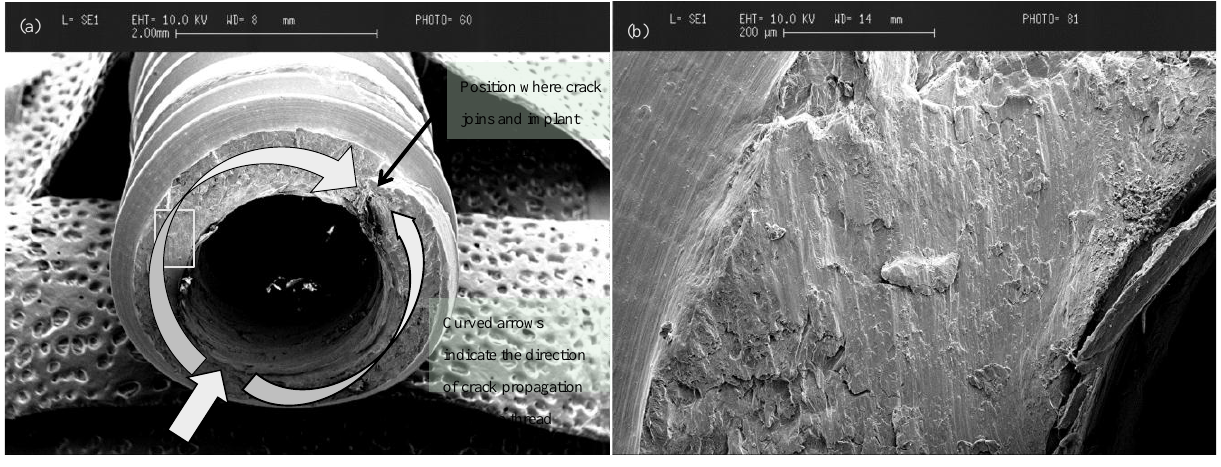
Figure 1. ( a ) Low magnification (×25) SEM image of fractured titanium implant. The crack in this instance was initiated on the lower left edge of the implant (lower straight arrow) and extended around the thread, finally breaking when the cracks overlapped on the upper right-hand side; ( b ) higher magnification (×500) view of the rectangular outlined area of the fractured surface in Figure 1a showing fatigue striations in a vertical pattern that mark the crack position as it